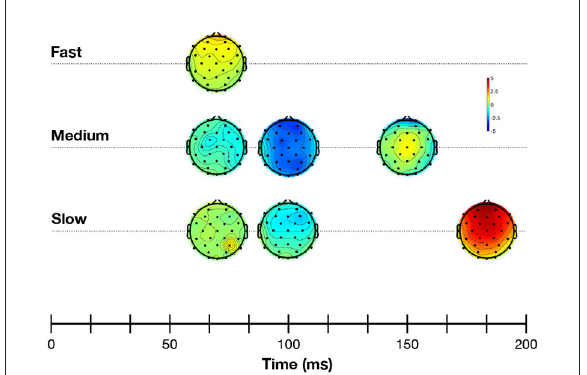
FIGURE5 Voltage maps showing mean cortical activity during the 50–200ms post-stimulus time window. Negative values are shown in blue, and positive values in red.